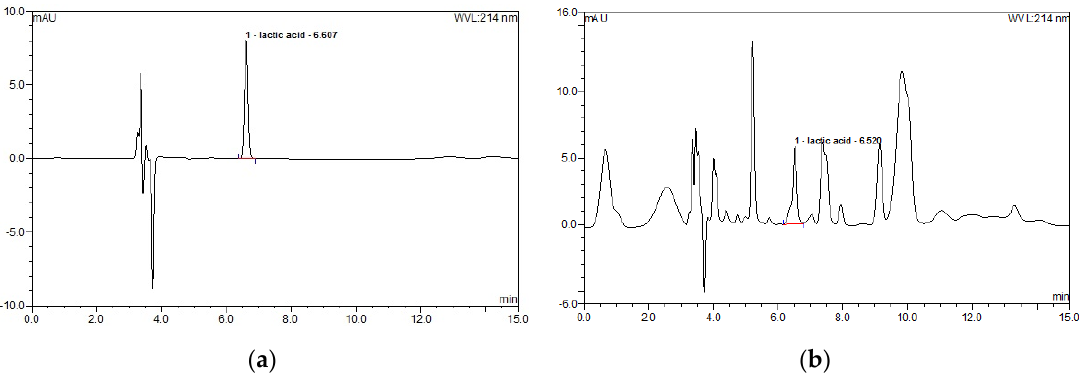
Figure 2. Chromatograms of standard lactic acid ( a ) and fermented oyster extract ( b ).